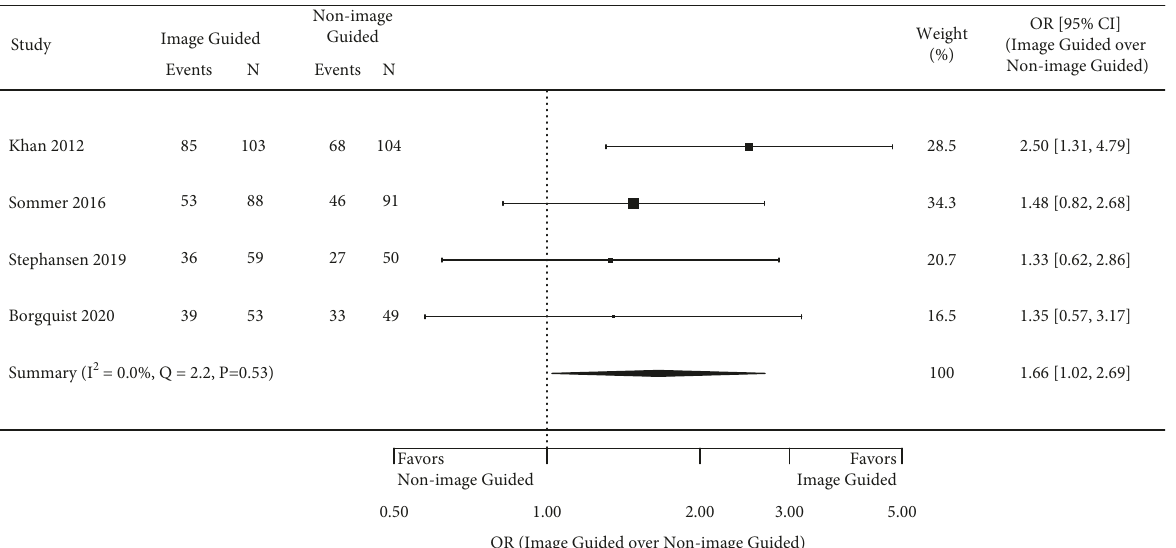
1 NYHA class improvement at 6 >